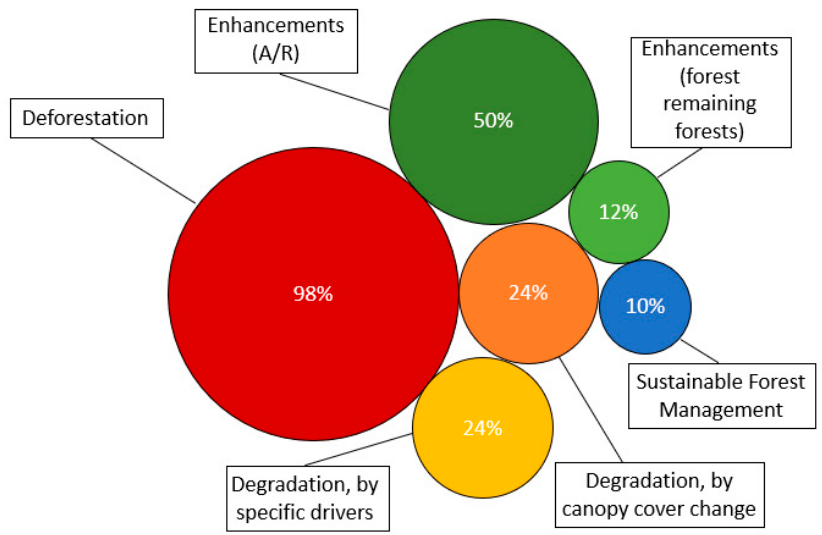
Figure 1. Proportion (%) of forest reference emission level / reference level (FREL / FRL) submissions to the UNFCCC that include the Reducing Emissions from Deforestation and forest Degradation (REDD + ) activities of deforestation (red), degradation (orange), enhancements (green), and sustainable forest management (blue). The size of the bubbles is proportional to the size of the sample. Degradation is represented by two mutually exclusive bubbles—i.e., countries either report degradation by driver activity or by canopy cover change.